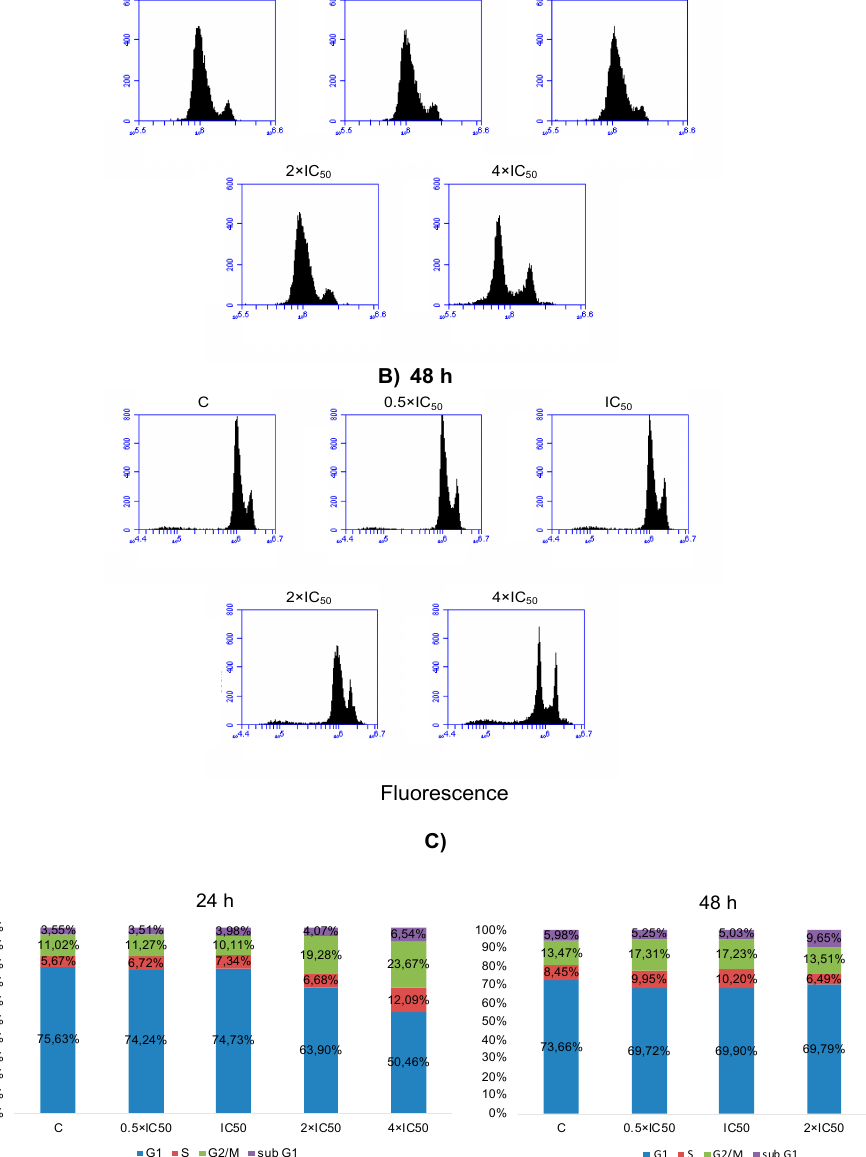
Figure 6. ( A ) DNA histograms of NCI-H929 cells treated with indicated concentrations of secalonic acid F (SAF) for 24 h, ( B ) DNA histograms of NCI-H929 cells treated with indicated concentrations of SAF for 48 h, and ( C ) Cell cycle distribution of NCI-H929 cells treated with indicated concentrations of SAF for 24 h and 48 h, respectively .